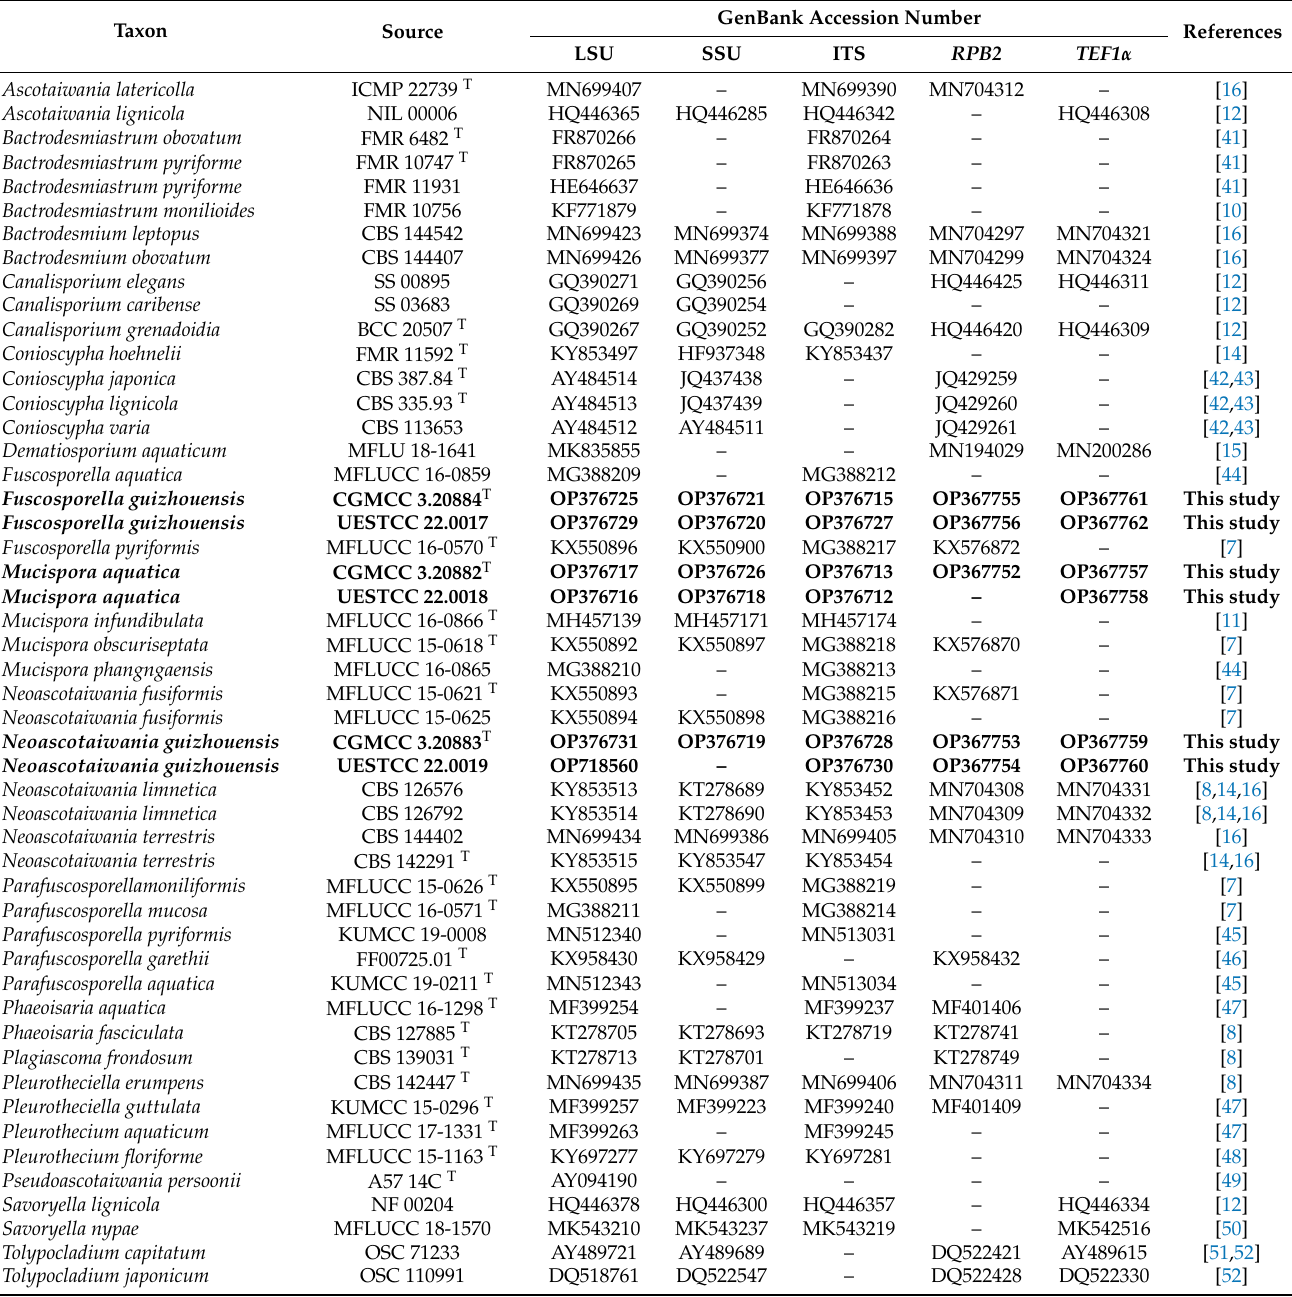
Table 1. Taxa used in the phylogenetic analyses and the corresponding GenBank accession